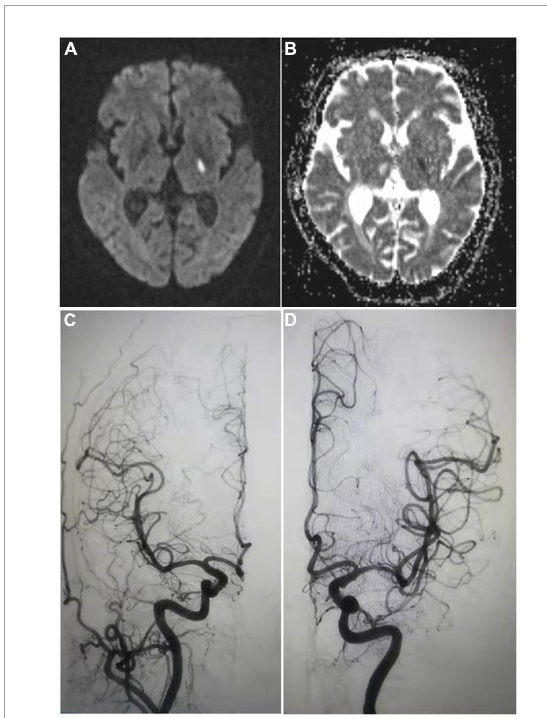
FIGURE1 Visible capsular infarction focus is detectable in the patients within 24 h of capsular warning syndrome (CWS) onset while under intravenous thrombolysis. Shown are examples of imaging results from patient #5 of the experimental group. (A) The high signal of diffusion-weighted imaging (DWI) sequence (B) and low signal of apparent diffusion coefficient (ADC) sequence in internal capsule. The anterior circulation angiography under digital subtraction angiography (DSA) shows that panel (C) the lumen of the right middle cerebral artery (MCA) was well developed, and panel (D) the lumen of the M1 segment of the left MCA was slightly narrow with rough wall, indicating atherosclerotic changes.